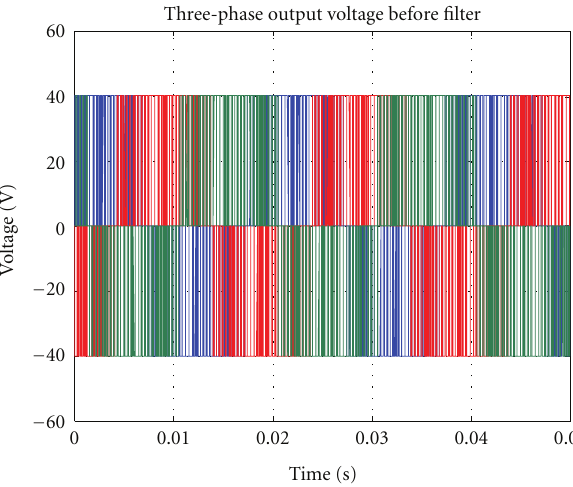
Figure 7: Three-phase inverter output voltage before the